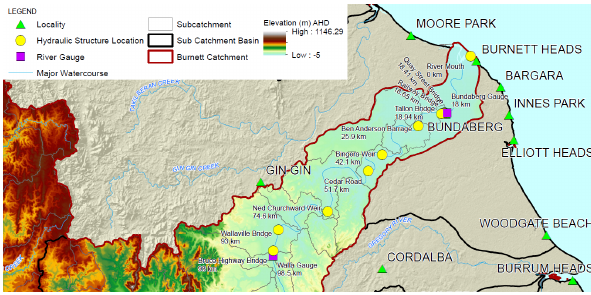
Figure 3. Burnett River catchment map (Bundaberg Regional Council, 2013b).